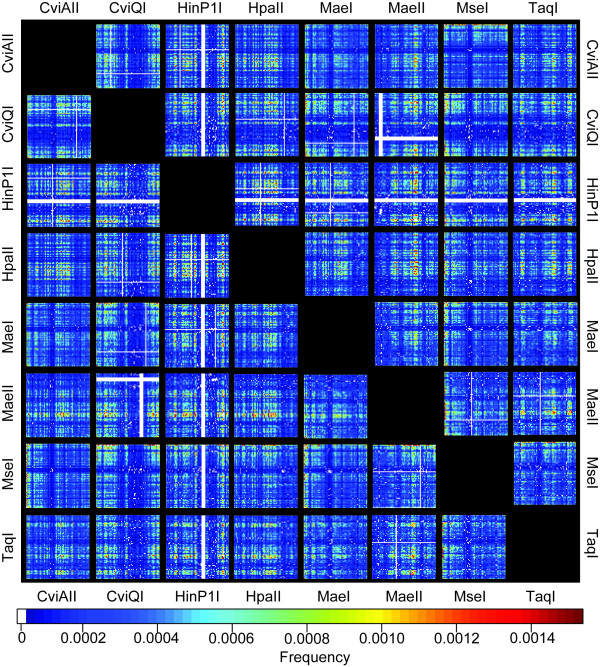
Characteristic cDNA-AFLP patterns are generated by individual restriction enzymes. Overview of the Homo sapiens selective cDNA-AFLP PCR arrays for all enzyme combinations tested here. The layout of arrays follows Figure 2. Note the consistent patterning of arrays, with characteristic ridges and trenches for enzyme combinations which contain the same enzyme. Arrays above the diagonal are mirror images of those below the diagonal. Selective primer combinations yielding no amplifications are highlighted in white. The pixel intensity indicates the relative proportion of fragments amplified in a given selective PCR combination.